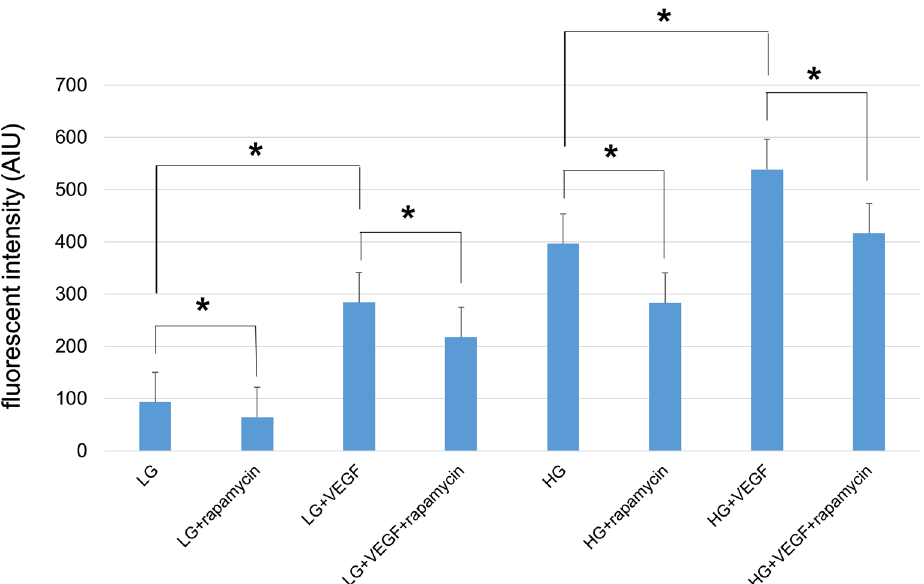
Figure 5. ROS levels in cultured Müller cells (TR-MUL5) exposed to rapamycin and/or VEGF under physiological (5.5 mM) and high-glucose (25 mM) conditions. Flow cytometry analyses showed significant increases in intracellular ROS levels in TR-MUL5 under a high-glucose condition, and these increases were significantly suppressed by rapamycin. In addition, flow cytometry analyses showed significant increases in intracellular levels of ROS in TR-MUL5 exposed to VEGF, and these increases were significantly suppressed by rapamycin ( P < 0.0018, the Bonferroni